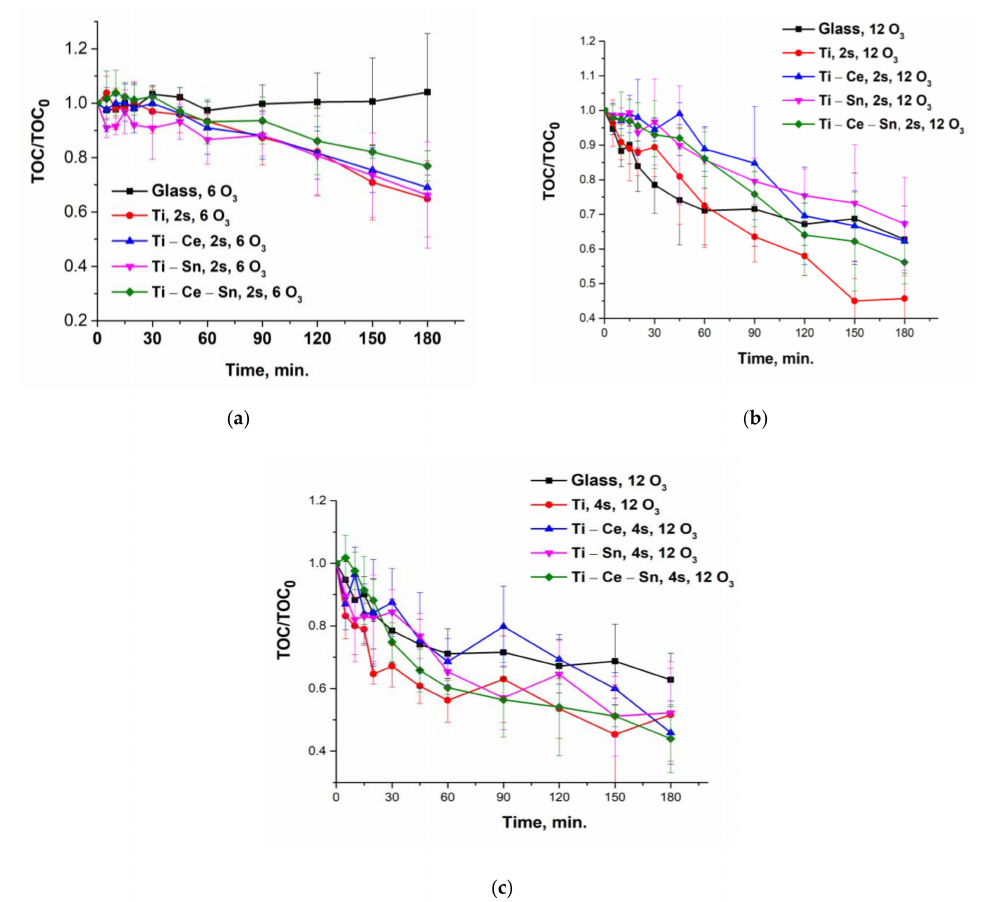
Figure 9. ( a ) Evolution of normalized TOC for all prepared systems at a lower ozone input and two slides; ( b ) Evolution of normalized TOC for all prepared systems at a higher ozone input and two slides; ( c ) Evolution of normalized TOC for all prepared systems at a higher ozone input and four